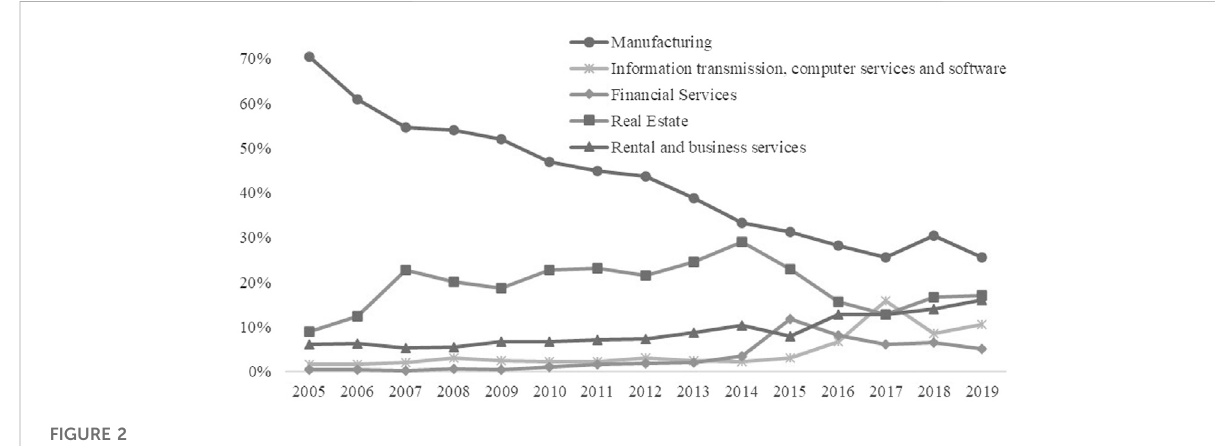
FIGURE 2 Distribution of FDI input industries (percentage).